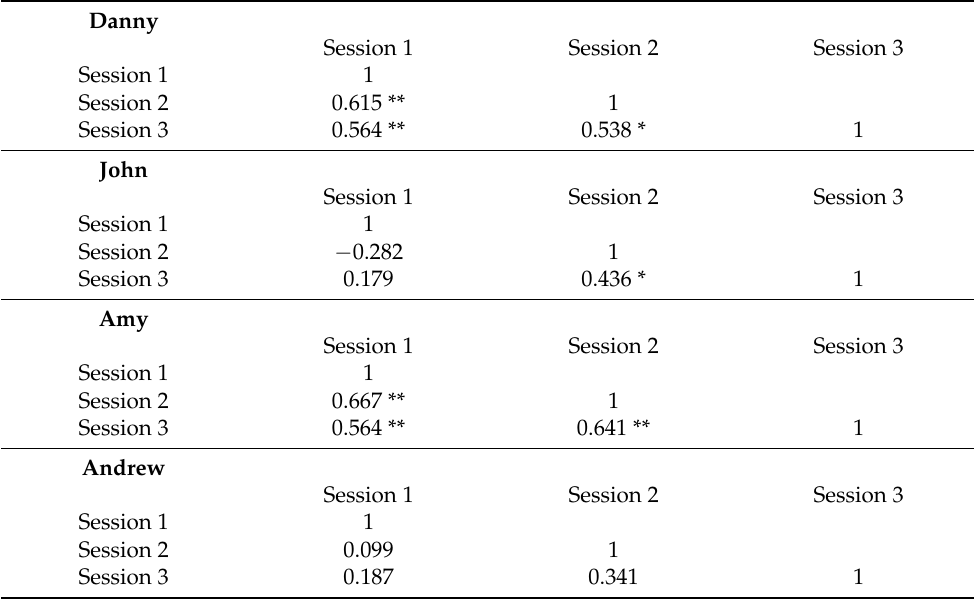
Table 2. Correlations of the three sessions of the pictorial concurrent operant assessment for each